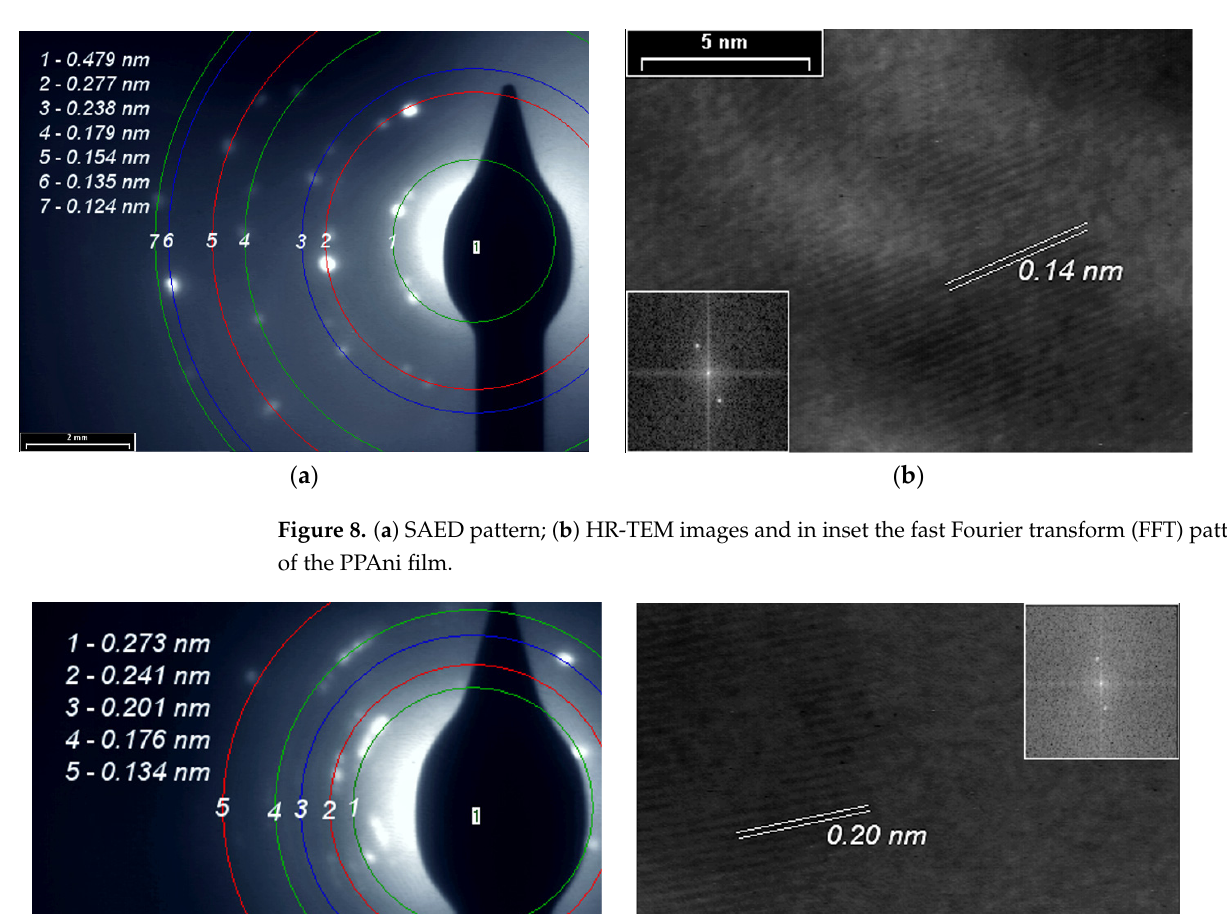
Figure 9. ( a ) SAED pattern; ( b ) HR-TEM images and in inset the fast Fourier transform (FFT) pattern of the PDPA film.